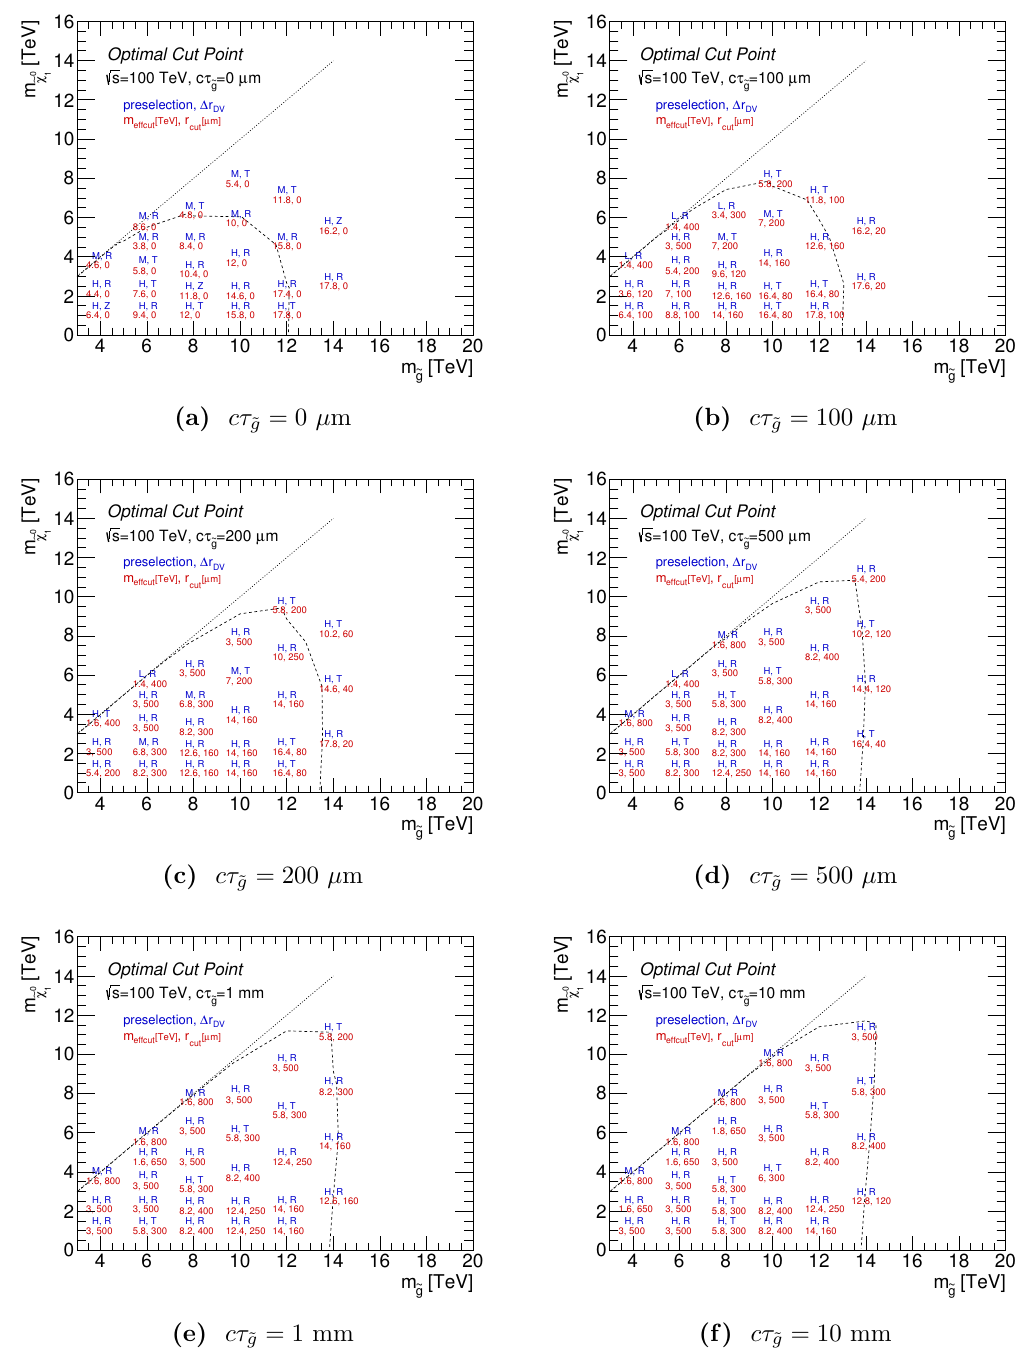
Figure 20. Optimal cut values (( m L , M , H ), and the e(cid:11)cut ) optimal , ( r cut ) optimal ), the preselection ( discriminator (cid:1) r DV ( R , T , Z ) for each sample point with various c(cid:28) ~ g , with an integrated luminosity of 3000 fb (cid:0) 1 . The expected 5 (cid:27) discovery reaches for gluinos are also shown in the dashed lines.